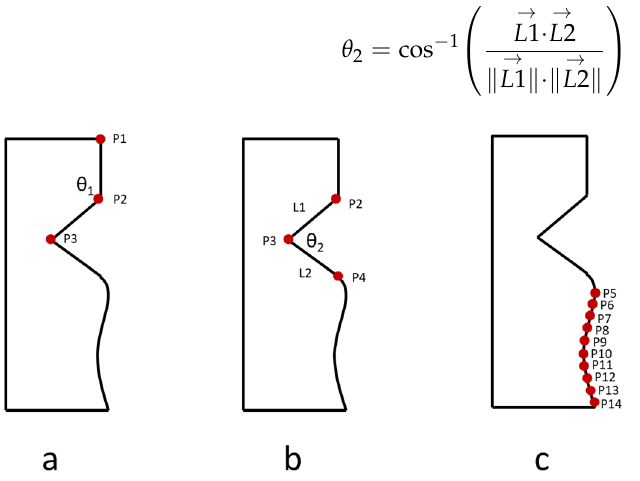
Figure 1. Illustration of the mating area that consists of straight line, triangle, and curve shapes. ( a ) keypoints to measure straight line, ( b ) keypoints to measure triangle, and ( c ) keypoints to measure curve.